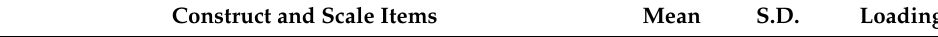
Table 3. Scale items with mean, standard deviation, and standardized